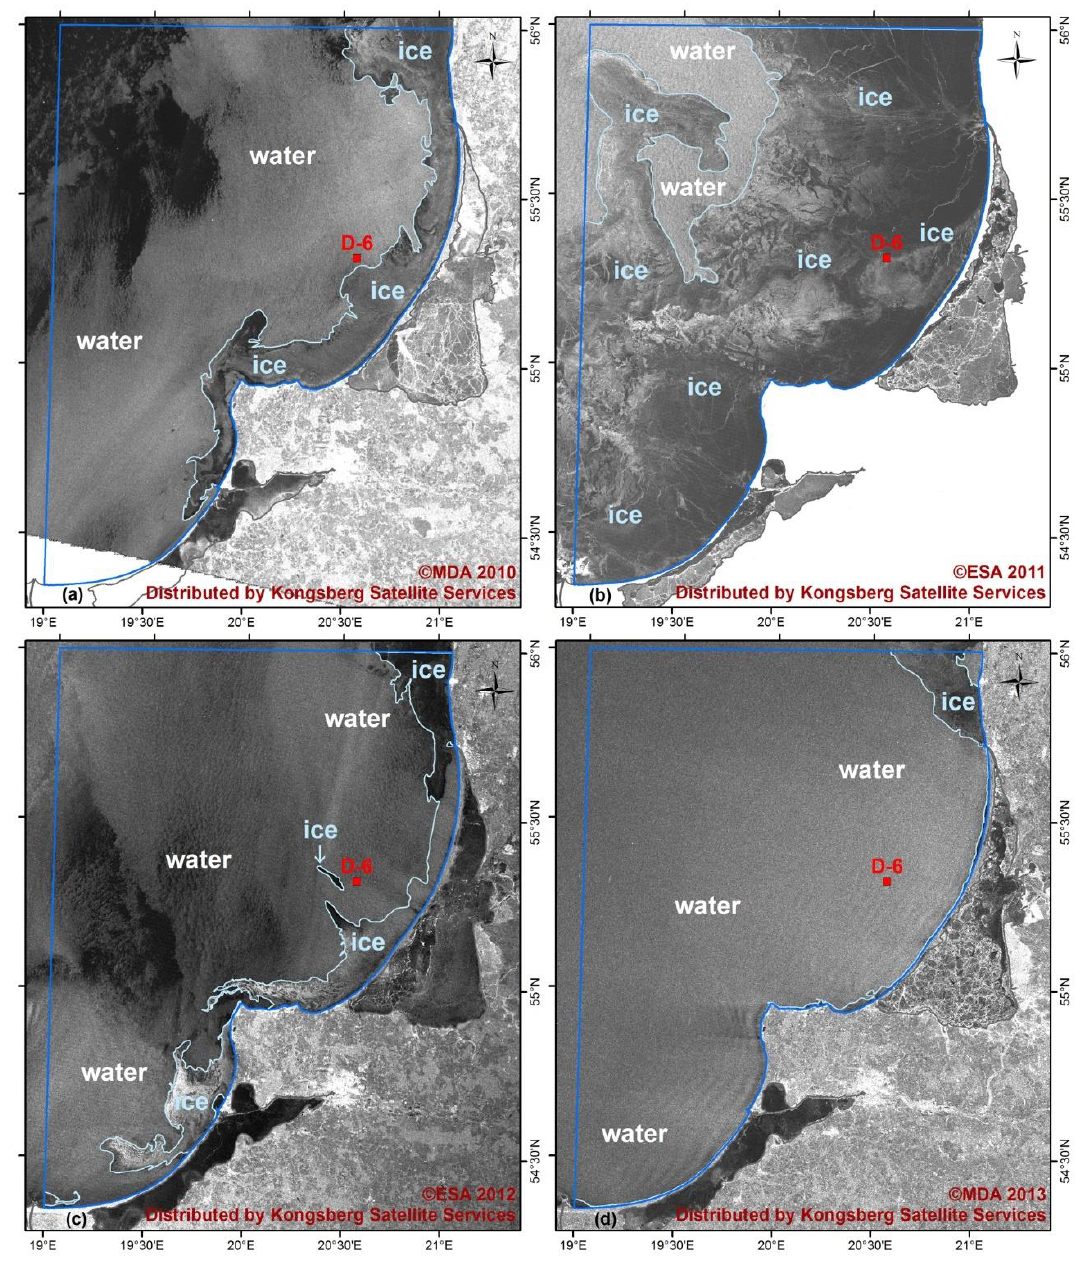
Figure 2. Maximum sea ice extent in the Southeastern Baltic Sea in winter seasons of 2009–2013 observed in spaceborne SAR data: ( a ) RADARSAT-2 on 8 February 2010 (05:05 UTC); ( b ) Envisat ASAR on 24 February 2011 (09:13 UTC); ( c ) Envisat ASAR on 11 February 2012 (09:10 UTC); ( d ) RADARSAT-2 on 23 January 2013 (05:05 UTC). Light blue contours mark the boundaries between the open water and the ice-covered regions.